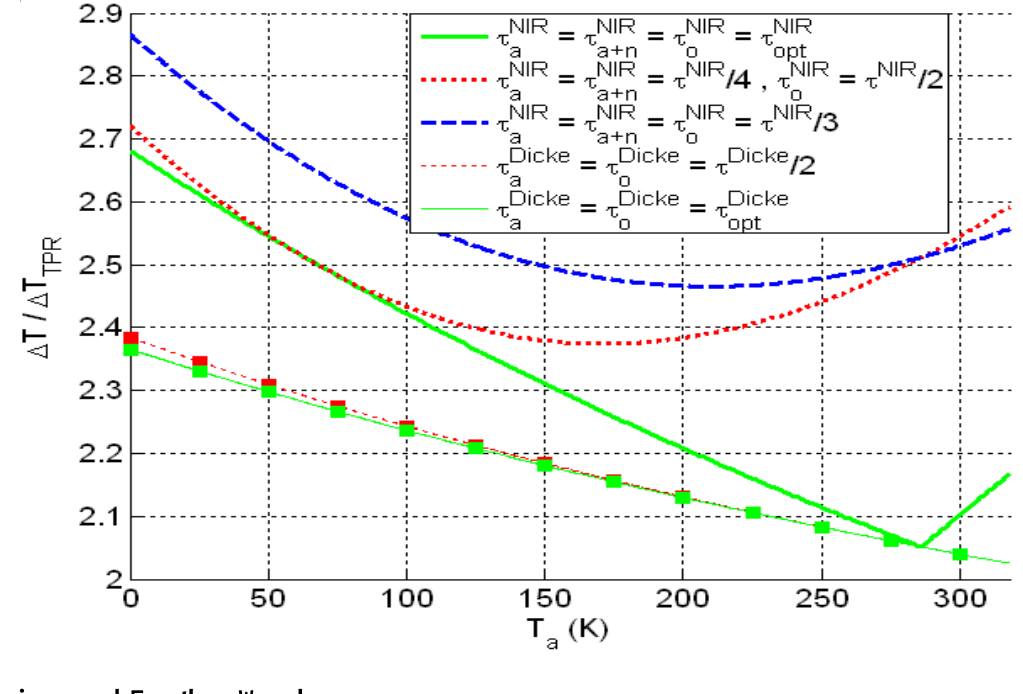
=  =  =  /3 (dotted A A+N REF